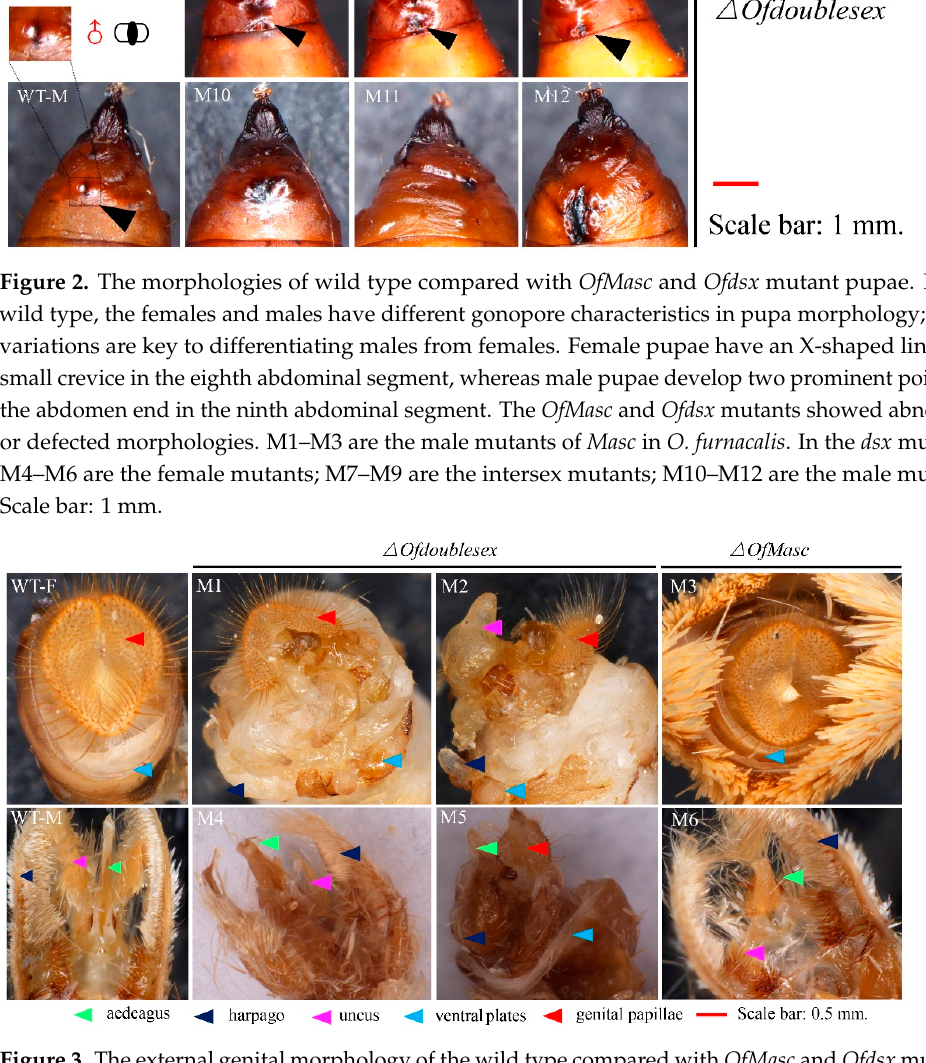
Figure 3. The external genital morphology of the wild type compared with OfMasc and Ofdsx mu- In the wild type, adult male external genitalia mainly consist of a harpago, some uncuses and an aedeagus. Female external genitalia mainly consist of a genital papilla and a ventral plate. The male-specific external genitalia in OfMasc and Ofdsx mutant males exhibited severe structural defects, and the genital papilla and ventral plate were not present and ectopic in Ofdsx mutant females. Scale bar: 0.5